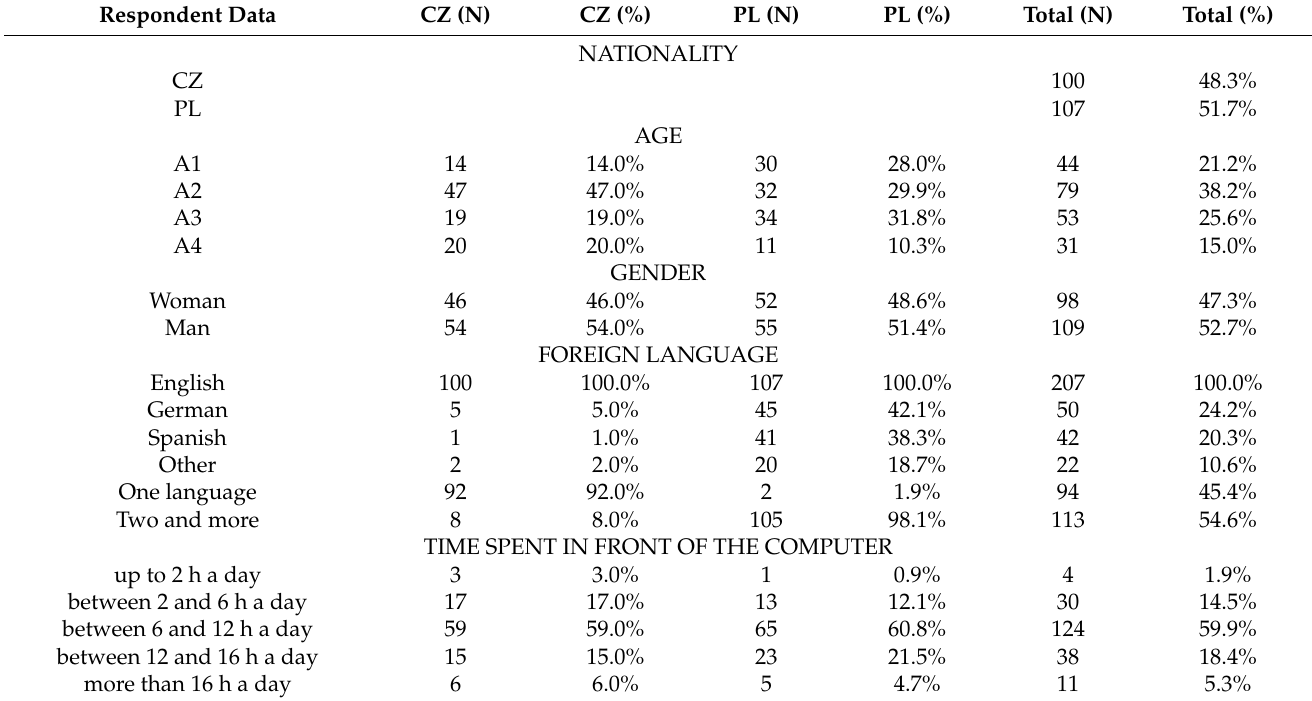
Table 1. Characterization of